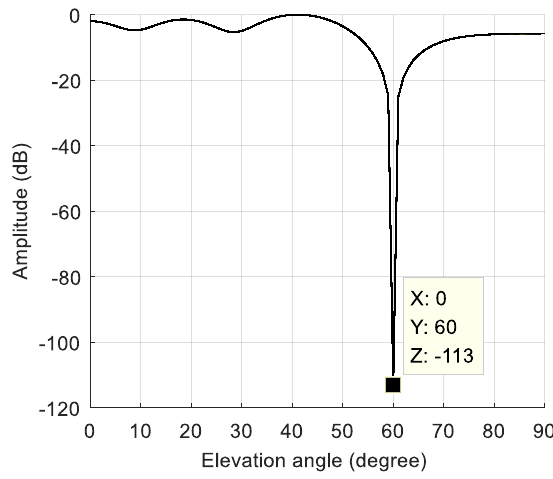
Figure 7. The null of the spatial filtering in the static scene.